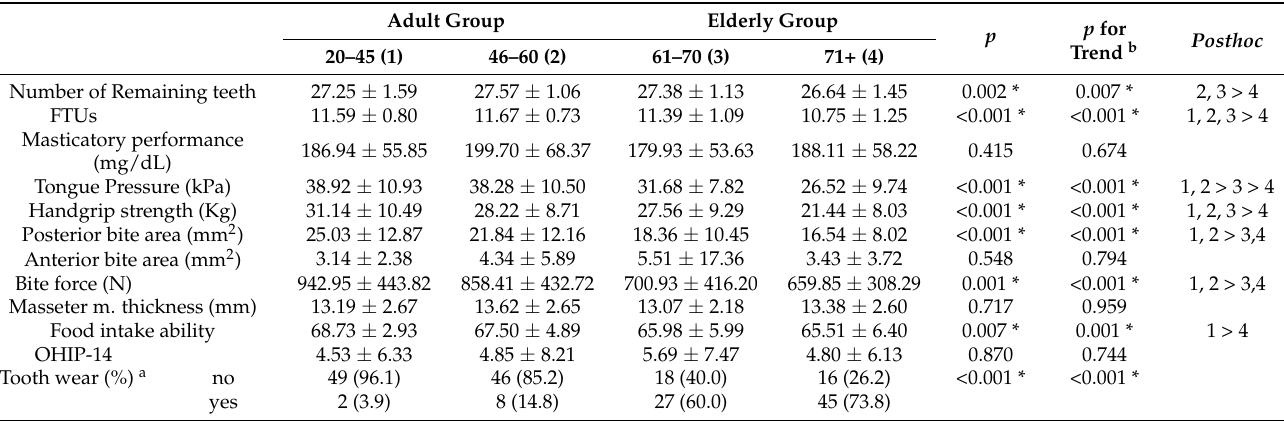
Table 2. Assessment of the variables of masticatory function among age